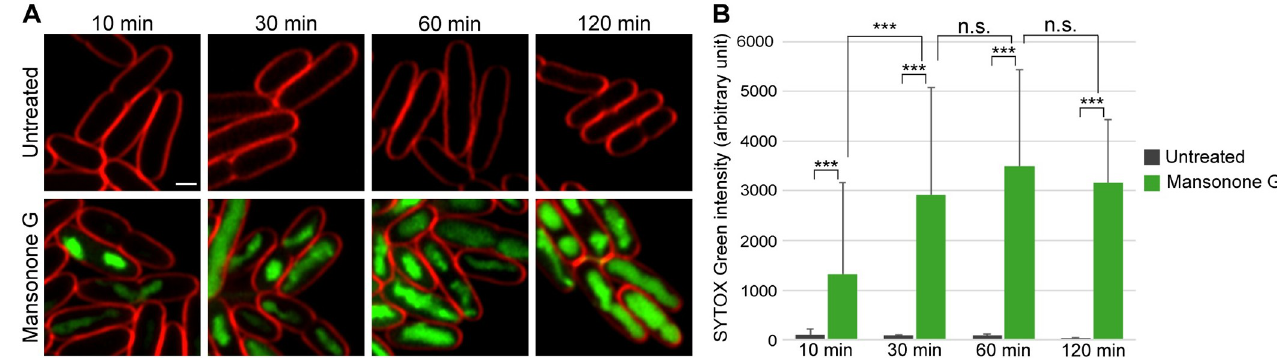
Fig 3. Mansonone G showing rapid membrane permeabilizing activity. E . coli lptD4213 cells were treated with mansonone G for 10, 30, 60 and 120 minutes, and then stained with FM4-64 (red) and SYTOX Green (green). (A) Upper panels show untreated samples and lower panels show mansonone G treatment. Scale bar represents 1 μ m. SYTOX Green intensity has been normalized to that of the brightest sample. (B) A graph showing differences in SYTOX Green intensities between untreated and mansonone G -treated cells at different timepoints. Values represent mean intensities ± STDEV of 45 to 100 individual nucleoids from single cells, per condition. ��� P < 0.001; two-tailed Student’s t-test, n.s.; not statistically significant.